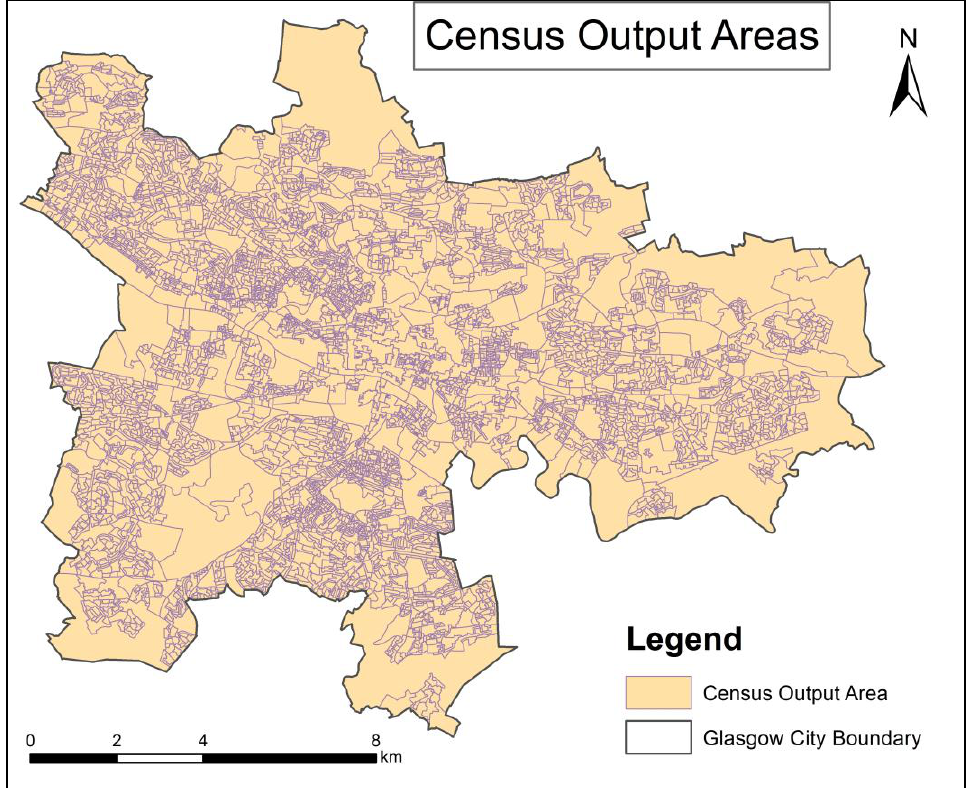
Figure 3. Census output areas in Glasgow (source: DATA.GOV.UK [52]).